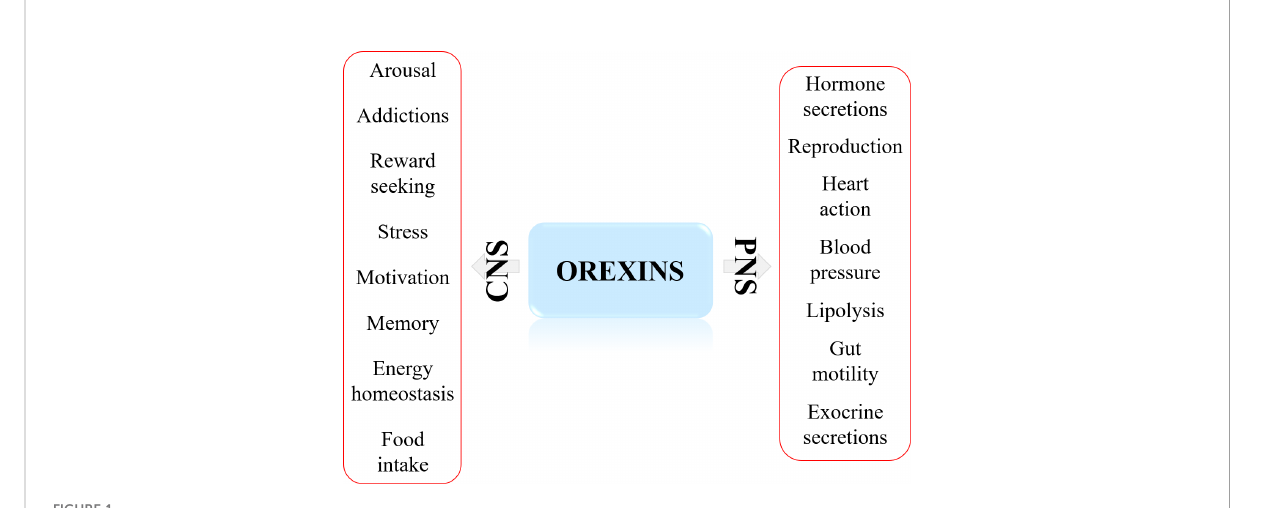
FIGURE 1 Major biological actions of orexins in central nervous system (CNS) and peripheral nervous system